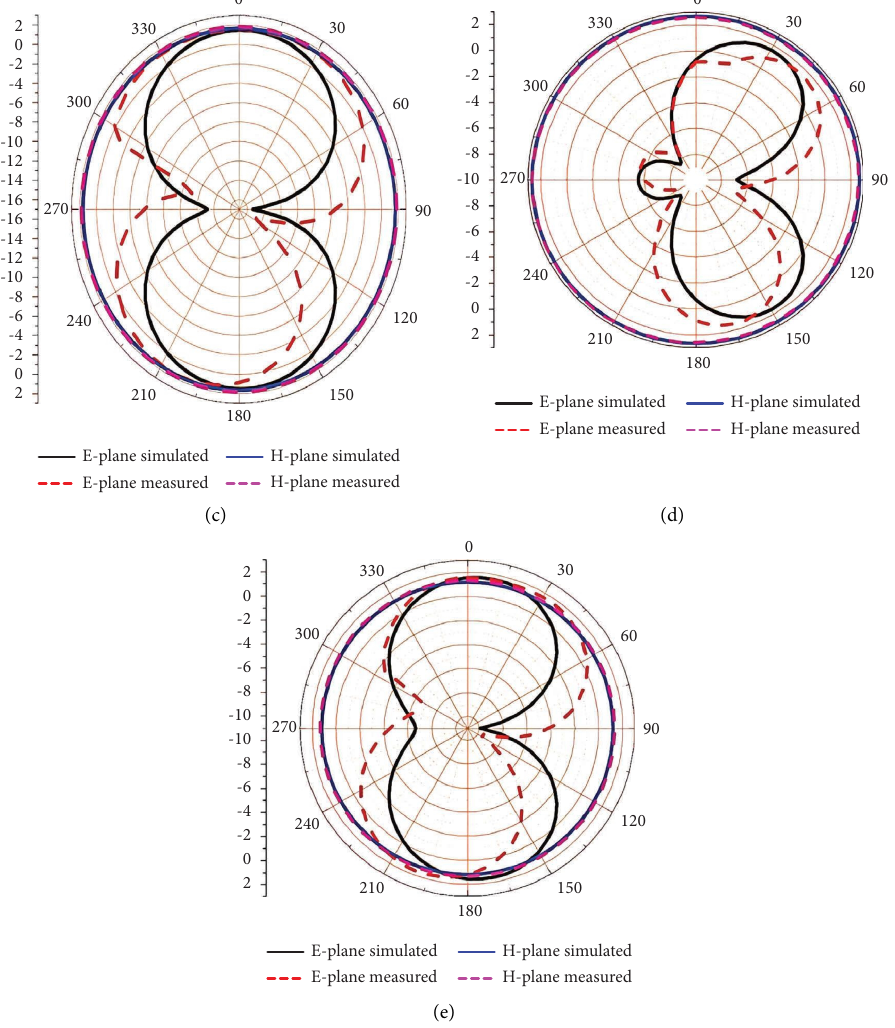
Figure 10: E plane and H plane of the proposed low-SAR penta-band microstrip patch antenna. (a) 3.01GHz. (b) 3.83GHz. (c) 4.14 GHz. (d) 5.46GHz. (e) 6.04 GHz.